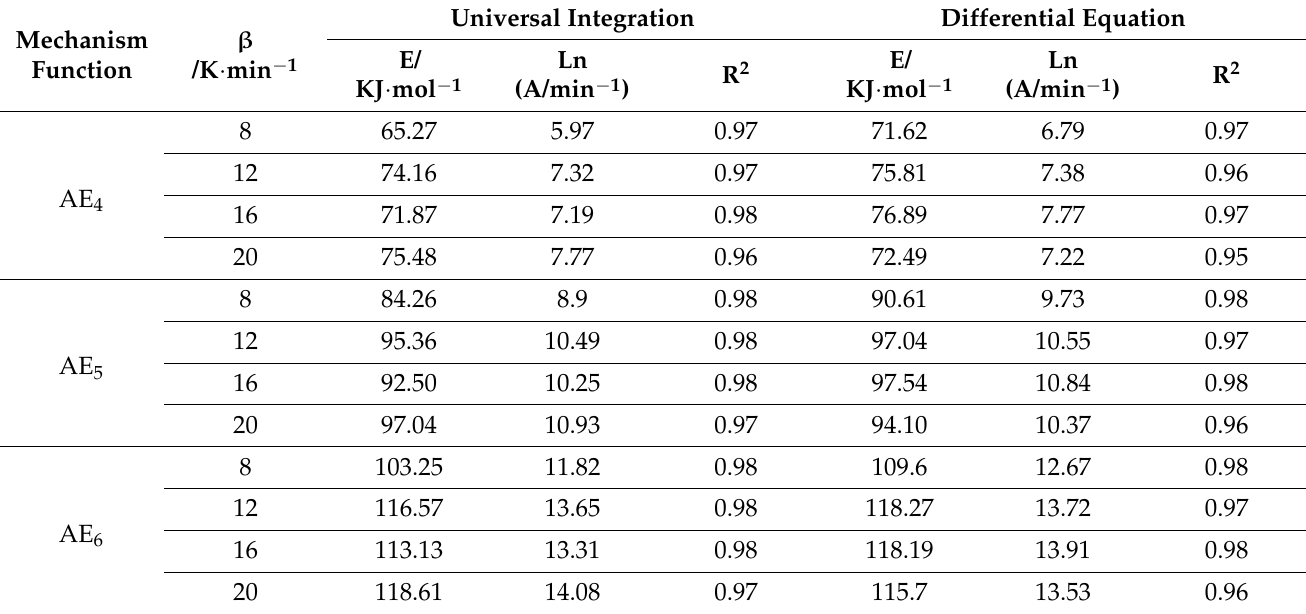
Table 4. Kinetic parameters of universal integral equations and differential equations based on the Avrami-Erofeev equation at different temperature rates of